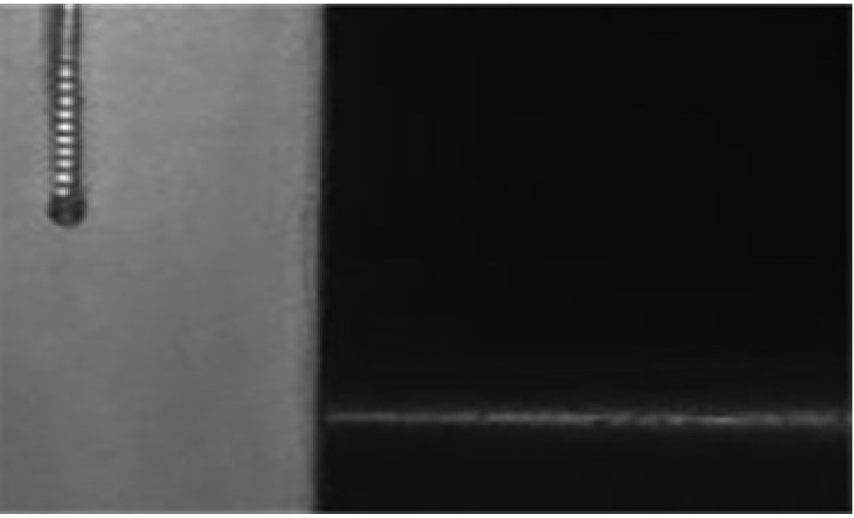
Figure 2. Image of the strip steel edge region and background region.